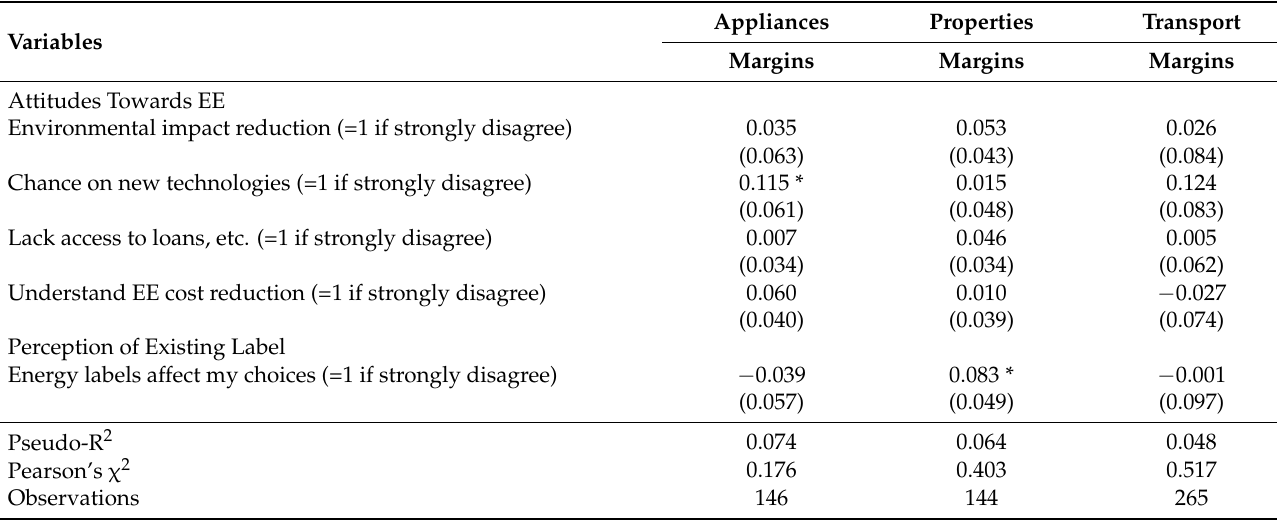
Table 13. Variables affecting firms’ perceptions of energy efficiency—probit marginal effects (technology subsamples). Variables